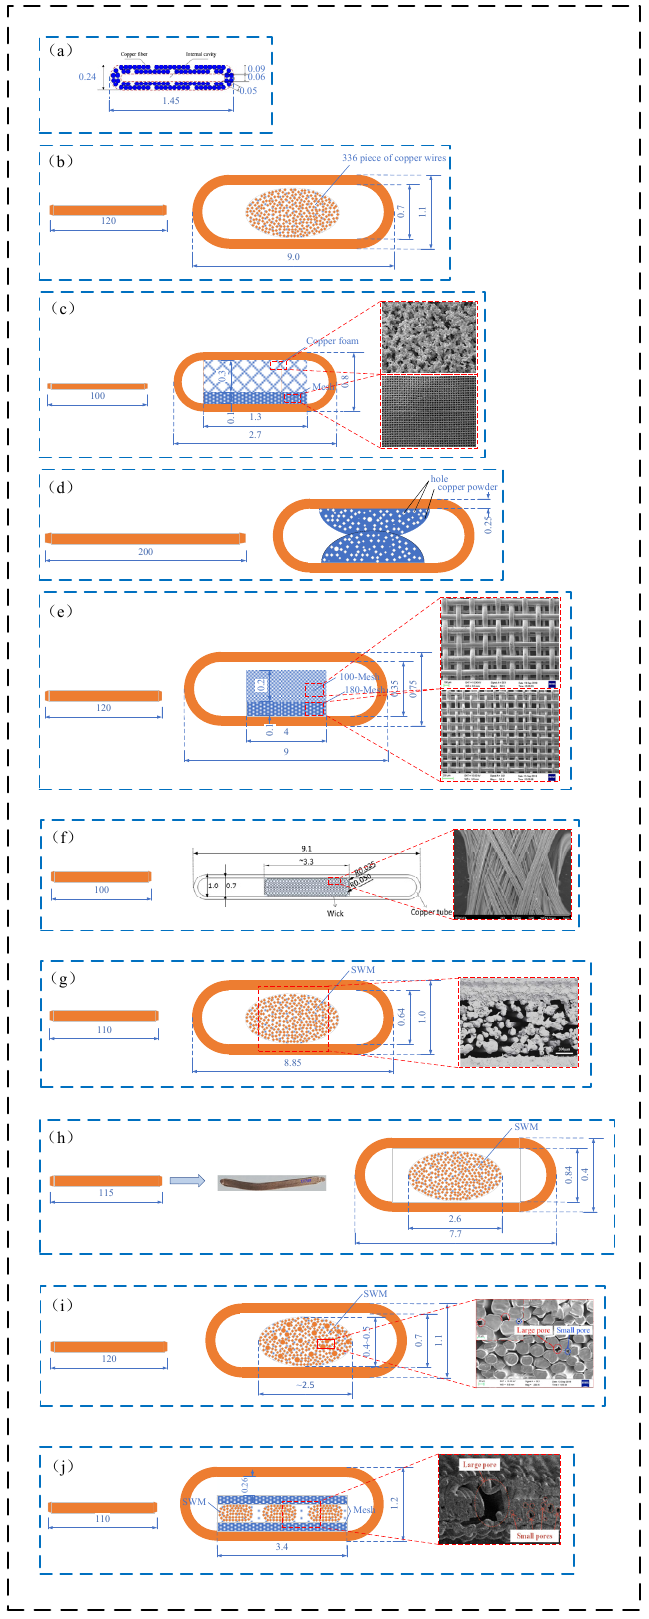
Figure 9. Schematic diagram, cross-sectional, and SEM images view of the internal structure of different ultra-thin flat heat pipes. SWM heat pipe: ( a ) [50], ( b ) [18], ( g ) [40], ( h ) [11]; composite wick heat pipe: ( c ) [45], ( e ) [55], ( f ) [52], ( i ) [41], ( j ) [56]; copper powder wick heat pipe: ( d ) [48] (unit: mm).